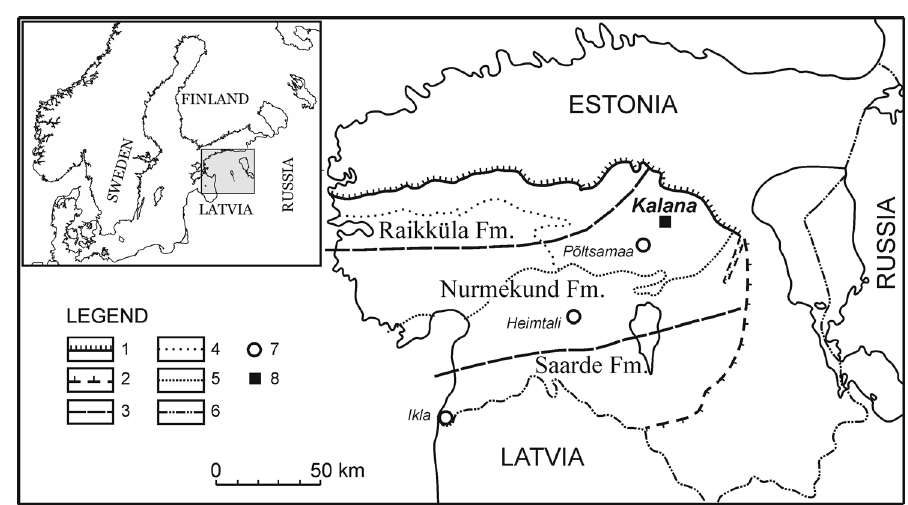
Fig. 1. Distribution of the Raikküla Regional Stage in Estonia and location of the sections discussed in the text (modified from Nestor H. et al. 2003). Legend: 1, limit of the Raikküla Stage in the outcrop area; 2, limit of the stage in the subsurface area; 3, geographical boundaries between formations in the Raikküla Stage; 4, limit of the overlying Adavere Stage in the outcrop area; 5, northern limit of overlying Middle Devonian strata; 6, state boundaries; 7, core sections; 8, Kalana